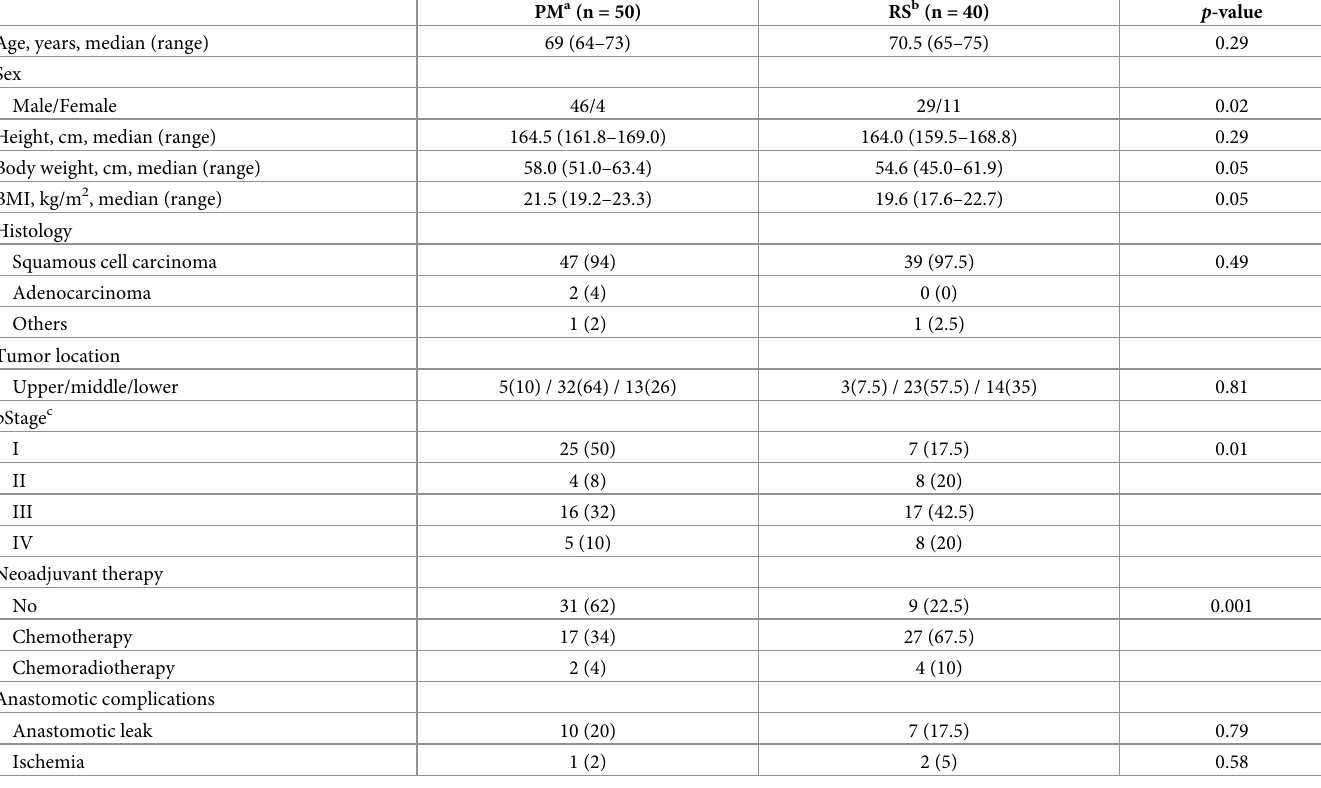
Table 1. Characteristics of each reconstruction route group.